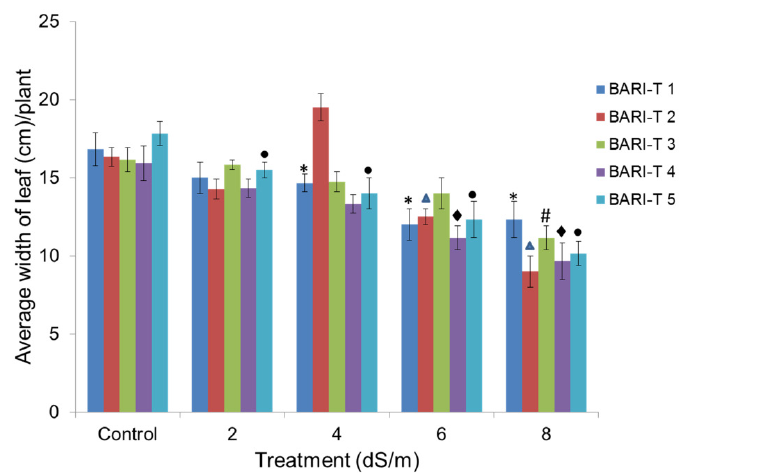
Fig. 3. Effects of NaCl-salinity on width of the leaf in five BARI-T plants. Error bars indicate mean ± SD (n=3). Asterisk *, , #, ♦ , and • denote a significant difference between the saline-treated group and control group of BARI-T 1, BARI-T 2, BARI-T3, BARI-T 4 and BARI-T 5, respectively at